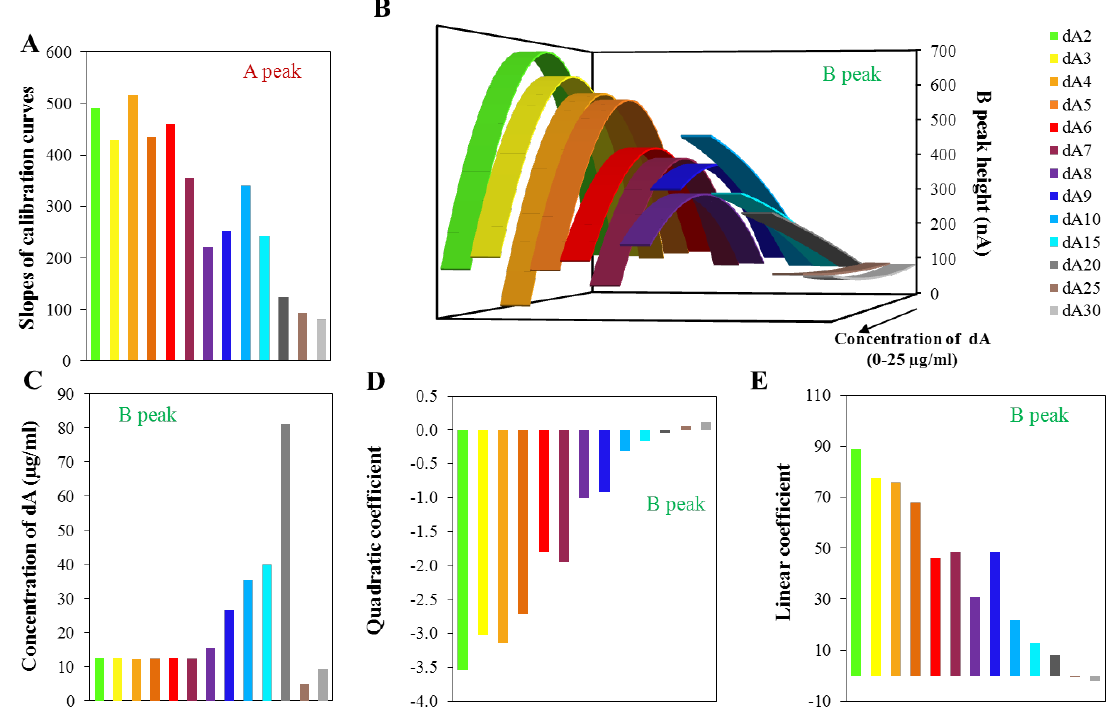
Figure 2. ( A ) Slopes of linear concentration dependencies obtained from evaluation of intensity of peak A within the concentration range from 50 ng/mL to 25 µg/mL of adenine nucleotide; ( B ) Calculated quadratic dependencies based on the measured data obtained for the peak B within the concentration range from 50 ng/mL to 25 µg/mL of adenine nucleotide; ( C ) Determined concentrations of adenine nucleotides related to the local maxima/minima of calculated quadratic dependencies for peak B; not restricted to model concentration interval of adenine nucleotide; ( D ) Dependence of quadratic coefficient calculated from quadratic dependencies on various number of adenine bases in strand; ( E ) Dependence of linear coefficient of calculated quadratic dependencies on the various number of adenine bases in